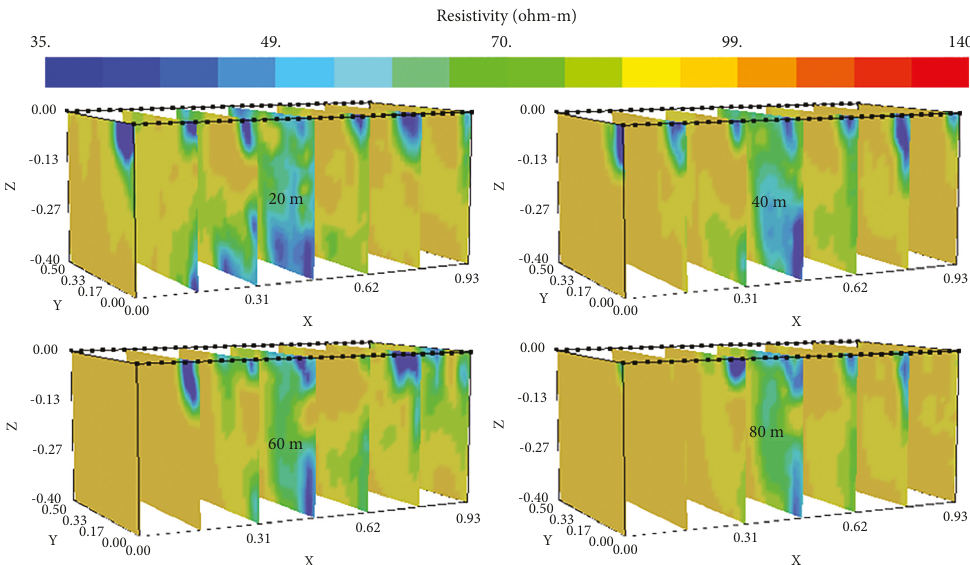
Figure 20: The resistivity section diagram along the x -axis direction at 40 cm above the coal seam.